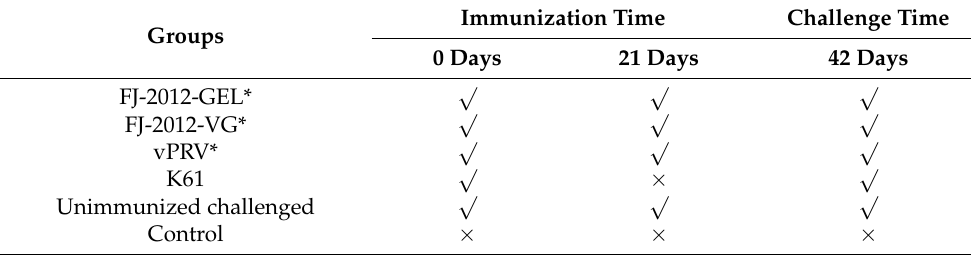
Table 2. Schedule and timepoint design of immunization and challenge in different groups.